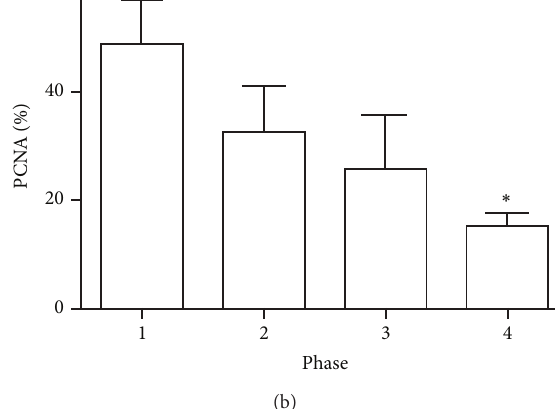
(Table 1). Based on this empirical data, the average distance